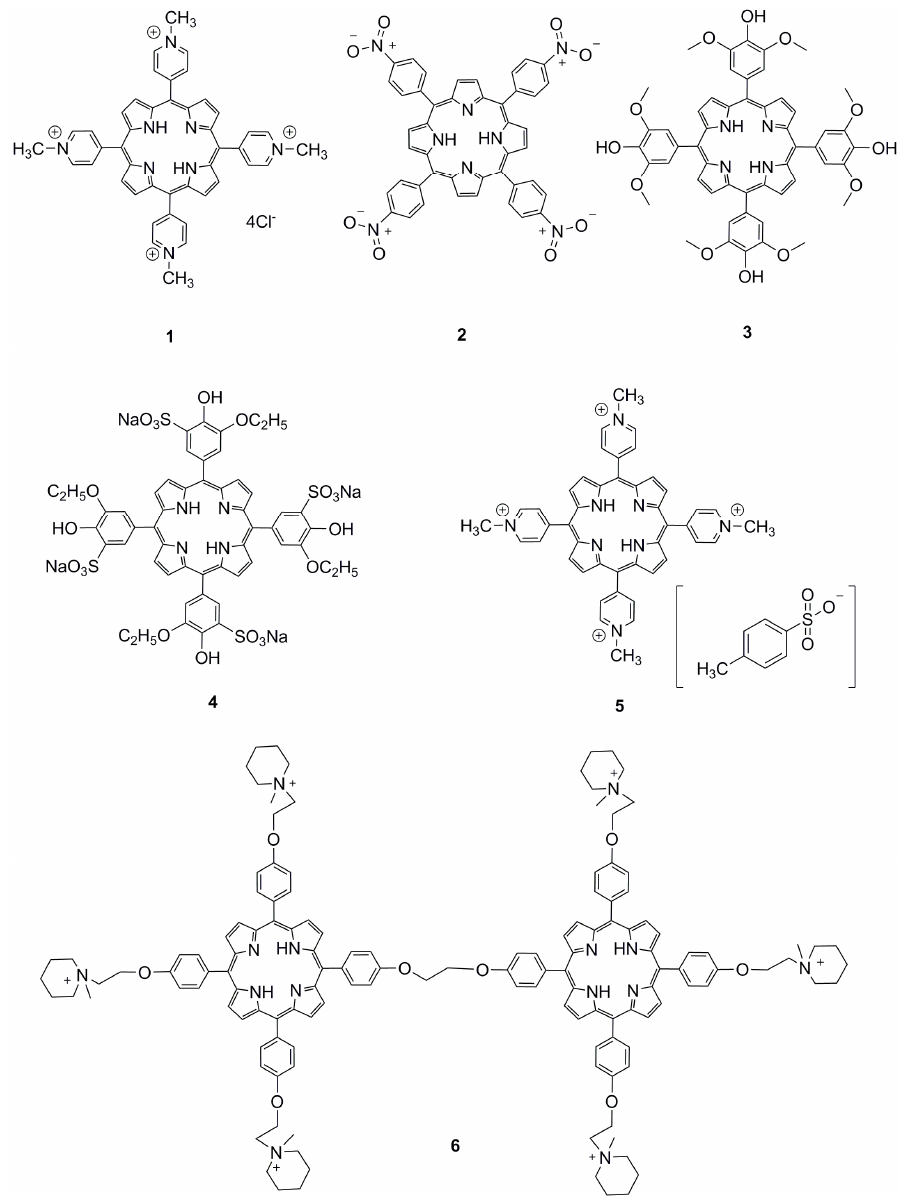
Figure 1. Ionic porphyrins. Reproduced from ref [32,34,39,43,81,82].